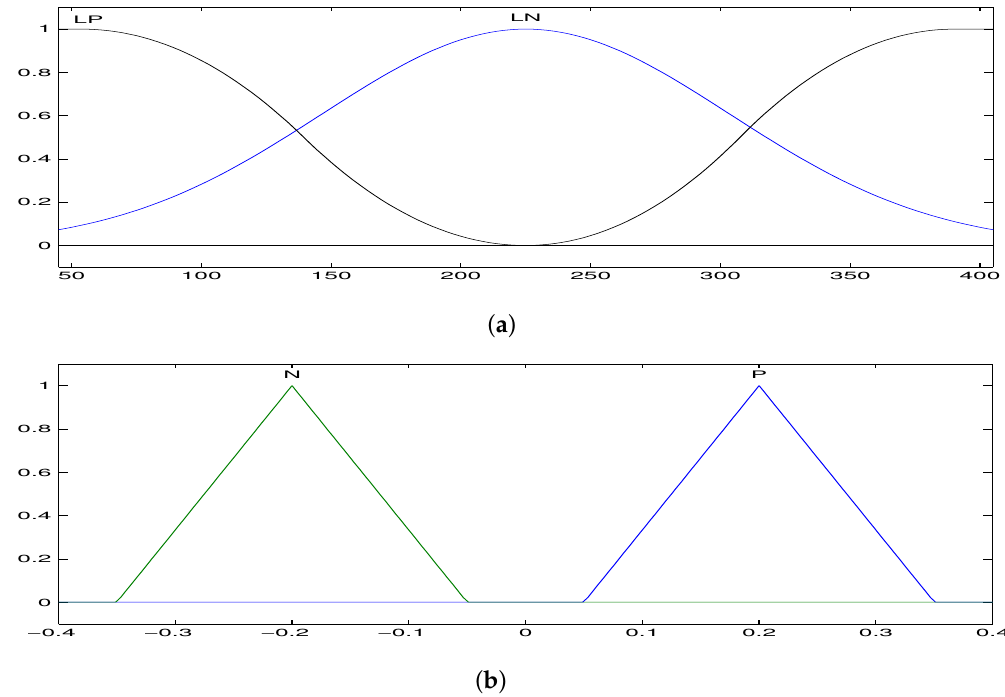
Figure 9. ( a ) Input membership functions for the second PF controller; ( b ) output membership functions for second PF